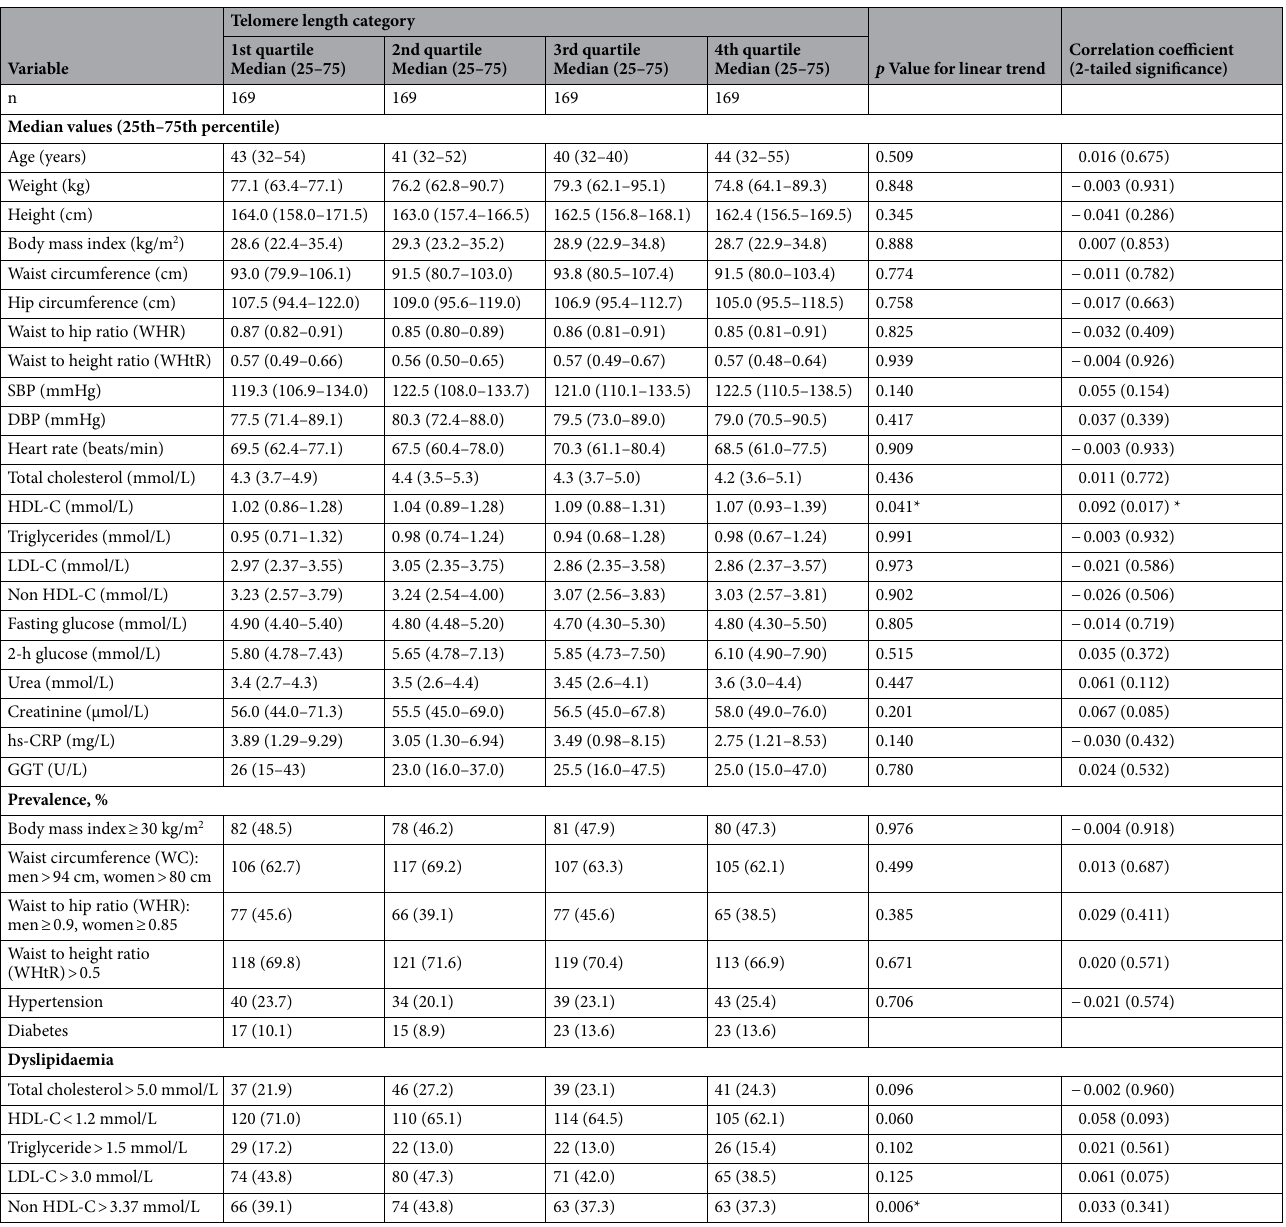
Table 3. Cardio-metabolic profile presented by telomere length quartiles. Legend: SBP systolic blood pressure, DBP diastolic blood pressure, WC waist circumference, WHR waist to hip ratio, WHtR waist to height